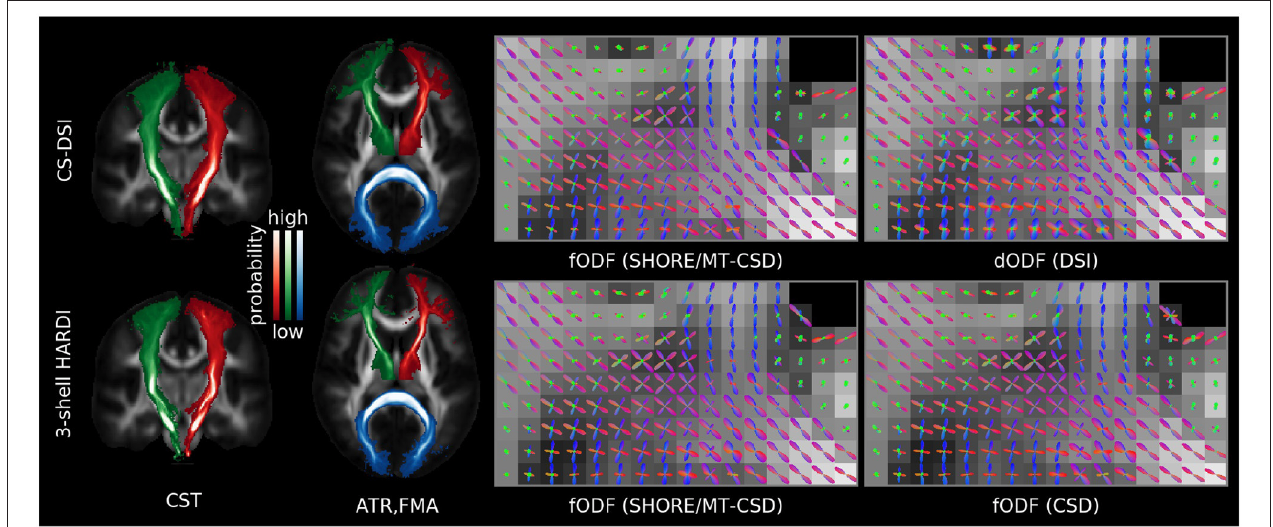
FIGURE 9 | Comparable orientational information can be extracted from both CS-DSI and 3-shell HARDI acquisitions. (Left) Group averaged tract probability maps are superimposed on the JHU ICBM FA white matter atlas for the left (red) and right (green) corticospinal tract (CST), the left (red) and right (green) anterior thalamic radiation (ATR) and in blue the forceps major (FMA). (Right) Single-subject fODFs obtained by means of the SHORE/MT-CSD model (SHORE order 8) for both CS-DSI and 3-shell HARDI and, only for the latter, by means of the CSD model. Single-subject dODFs are derived from the DSI